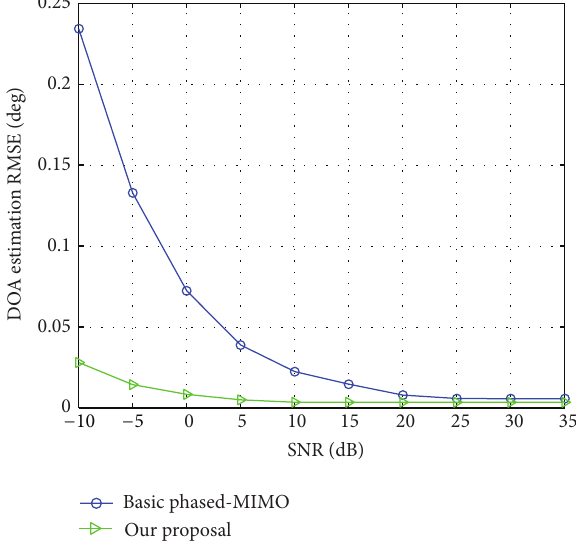
Figure 10: Comparative RMSE versus SNR for Example